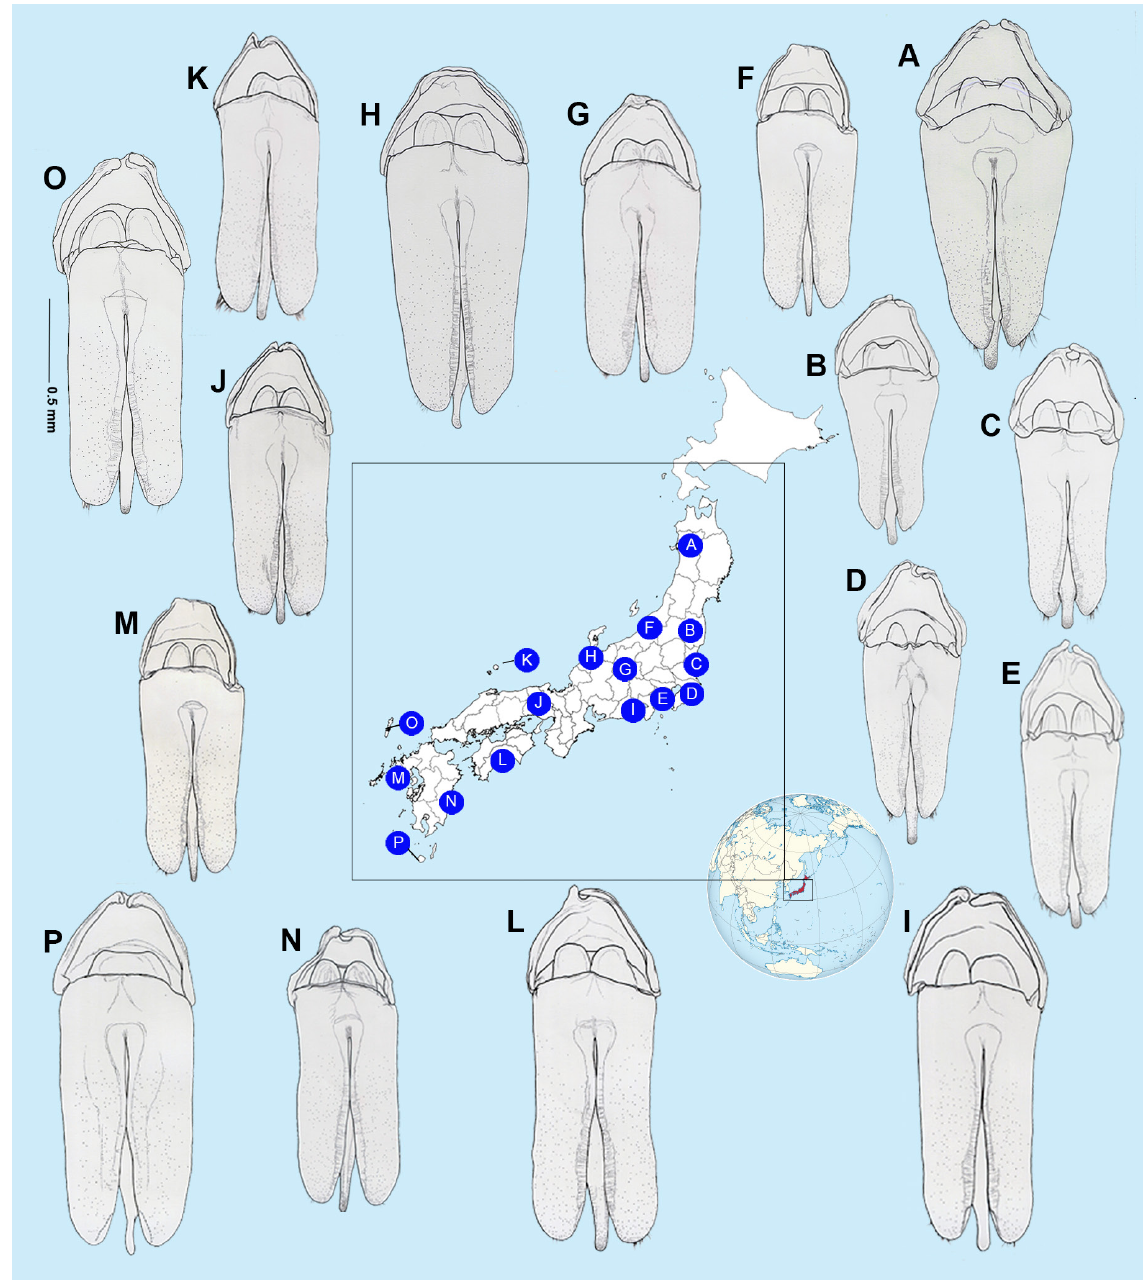
Fig. 10. Distribution of aedeagal patterns of Nipponoluciola cruciata (Motschulsky, 1854) gen. et comb. nov. in the Japanese islands; aedeagus dorsal view. Images by I. Kawashima. Map by W.F.A. Jusoh (Map of Japan using base maps obtained from Wikimedia Commons - Maximilian Dörrbecker and Connormah, CC BY-SA 3.0). A . Akita. B . Fukushima. C . Ibaraki. D . Chiba. E . Kanagawa. F . Niigata. G . Nagano. H . Ishikawa. I . Shizuoka. J . Hyogo. K . Oki Islands. L . Kochi. M . Nagasaki. N . Miyazaki. O . Tsushima Island. P . Yakushima